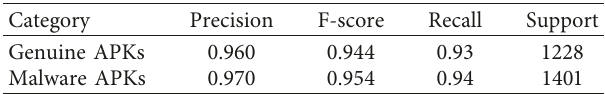
Table 3: Classification statistics using transfer learning (Malge-